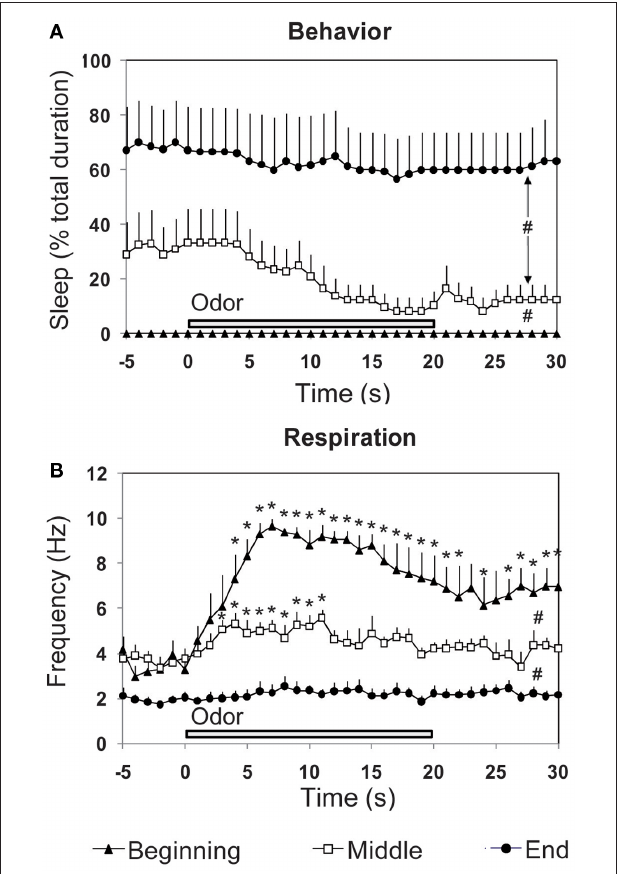
Figure 5 | effect of the introduction of a discrete stimulus (a new odor) on the time-course of (A) behavior and (B) respiration. The three parameters were recorded in odor animals ( n = 6), during a 30-s time window centered on odor presentation, at three periods of the experimental session (beginning, middle, and end). # Global significant difference between periods, p < 0.001. *Significant difference with pre-odor baseline, p